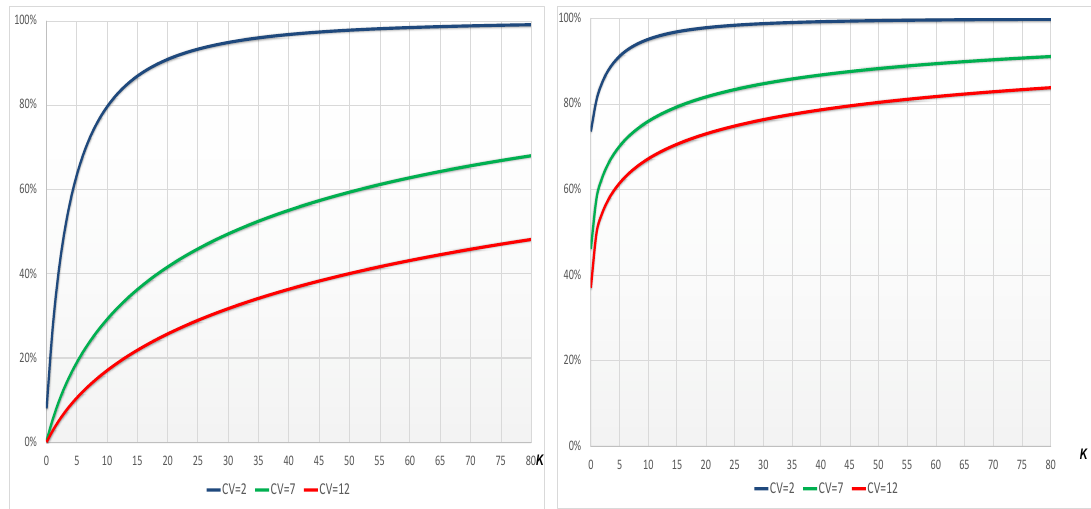
( Left ) and r ( Right ) for different c ˜ 2, ˜ Z 2, ˜ Z